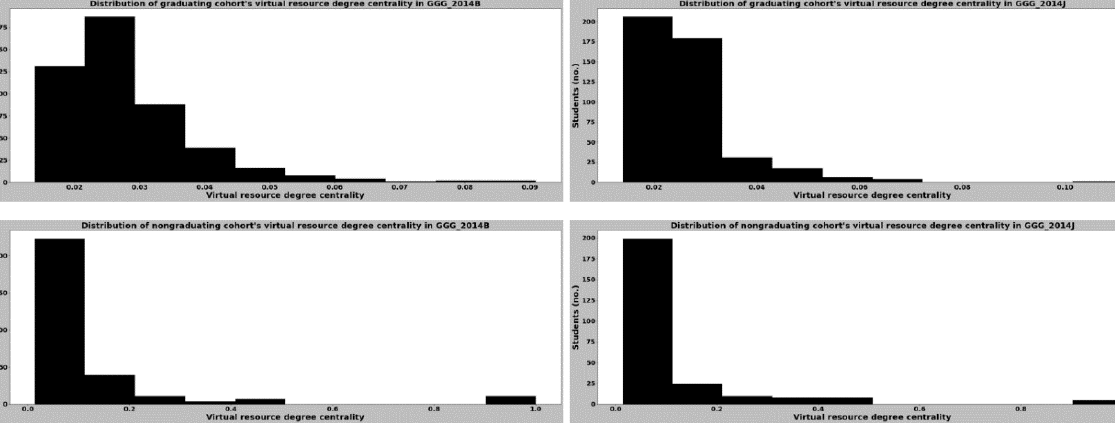
Figure 10 Distribution of Degree Centrality for Graduating and Nongraduating Cohorts in Course GGG in